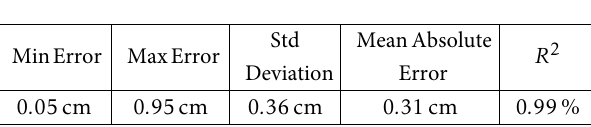
Table 2. System performanceon principalaxis measurement